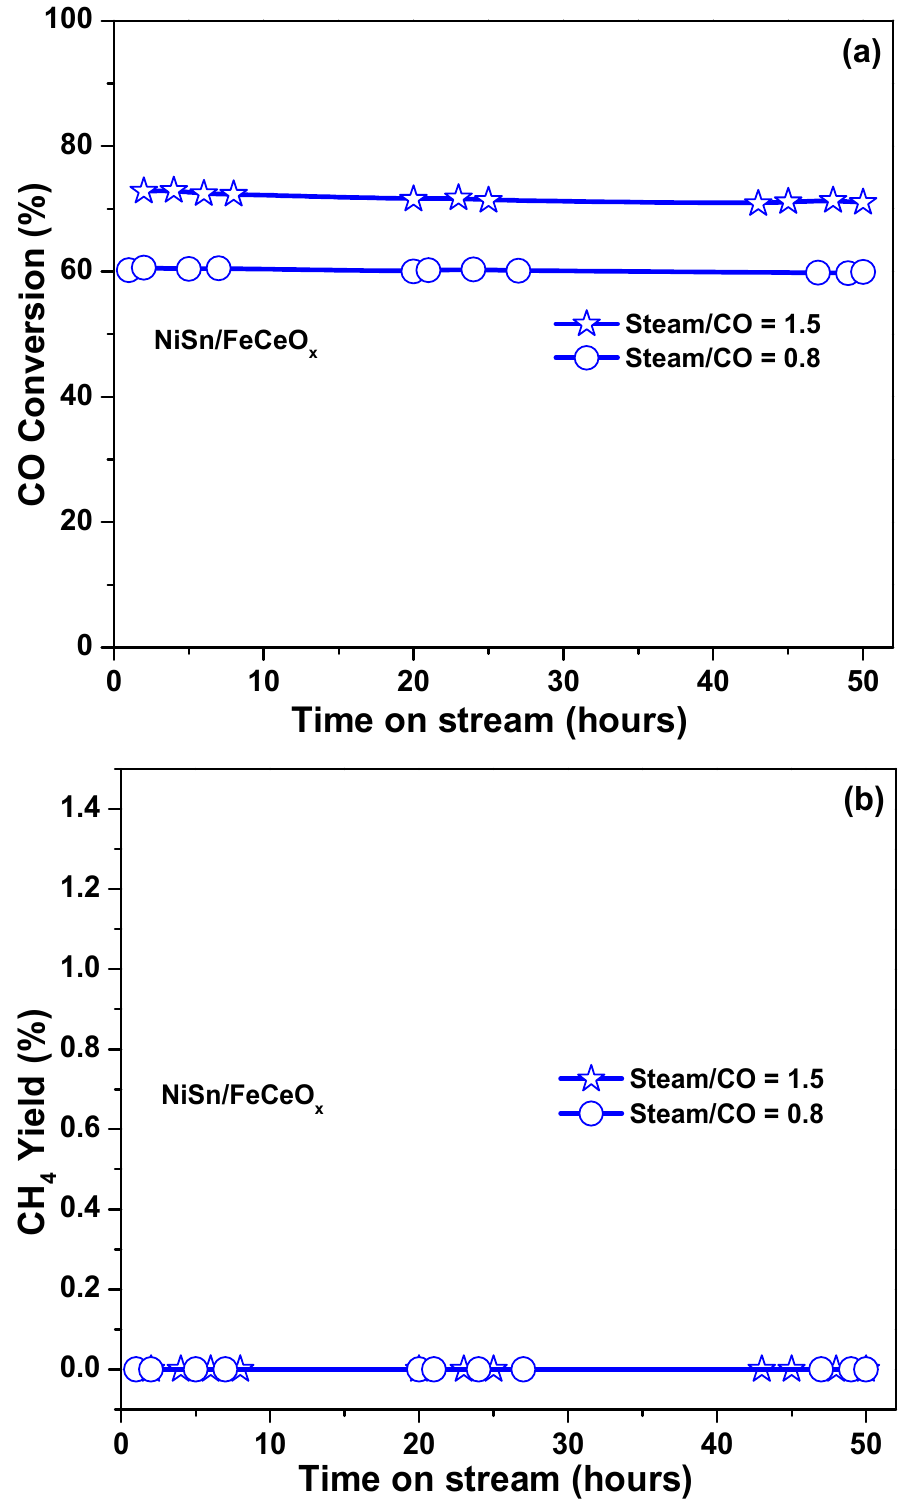
Figure 2. ( a ) CO conversion (%); ( b ) methane yield (%) with time on stream over the NiSn/FeCeO x catalyst (steam/CO = 1.5 and 0.8, T = 500 °C).